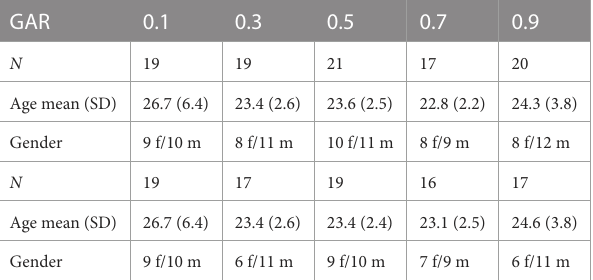
TABLE1 Top:descriptivestatisticsofparticipants ( n = 96 ) forattitudinaland interactionbehaviormeasures.Bottom:descriptivestatisticsofparticipants ( n = 88 )